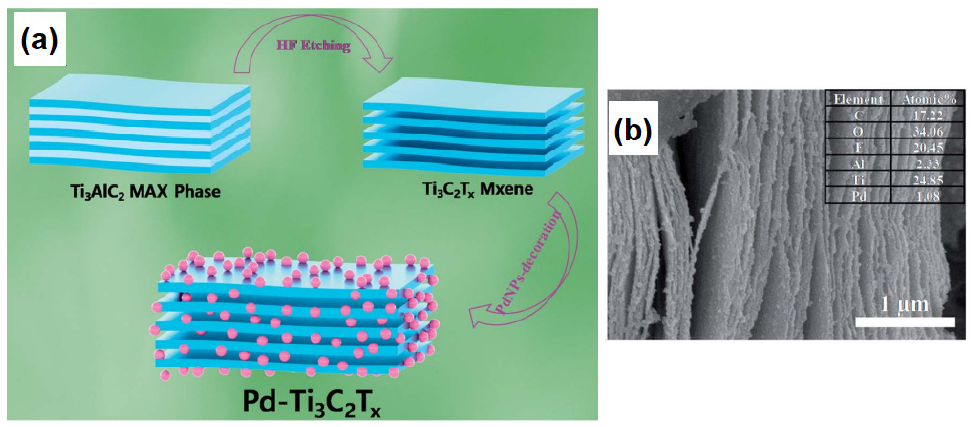
Figure 15. ( a ) Schematic illustration of Pd-Ti 3 C 2 T x formation. ( b ) SEM image of the